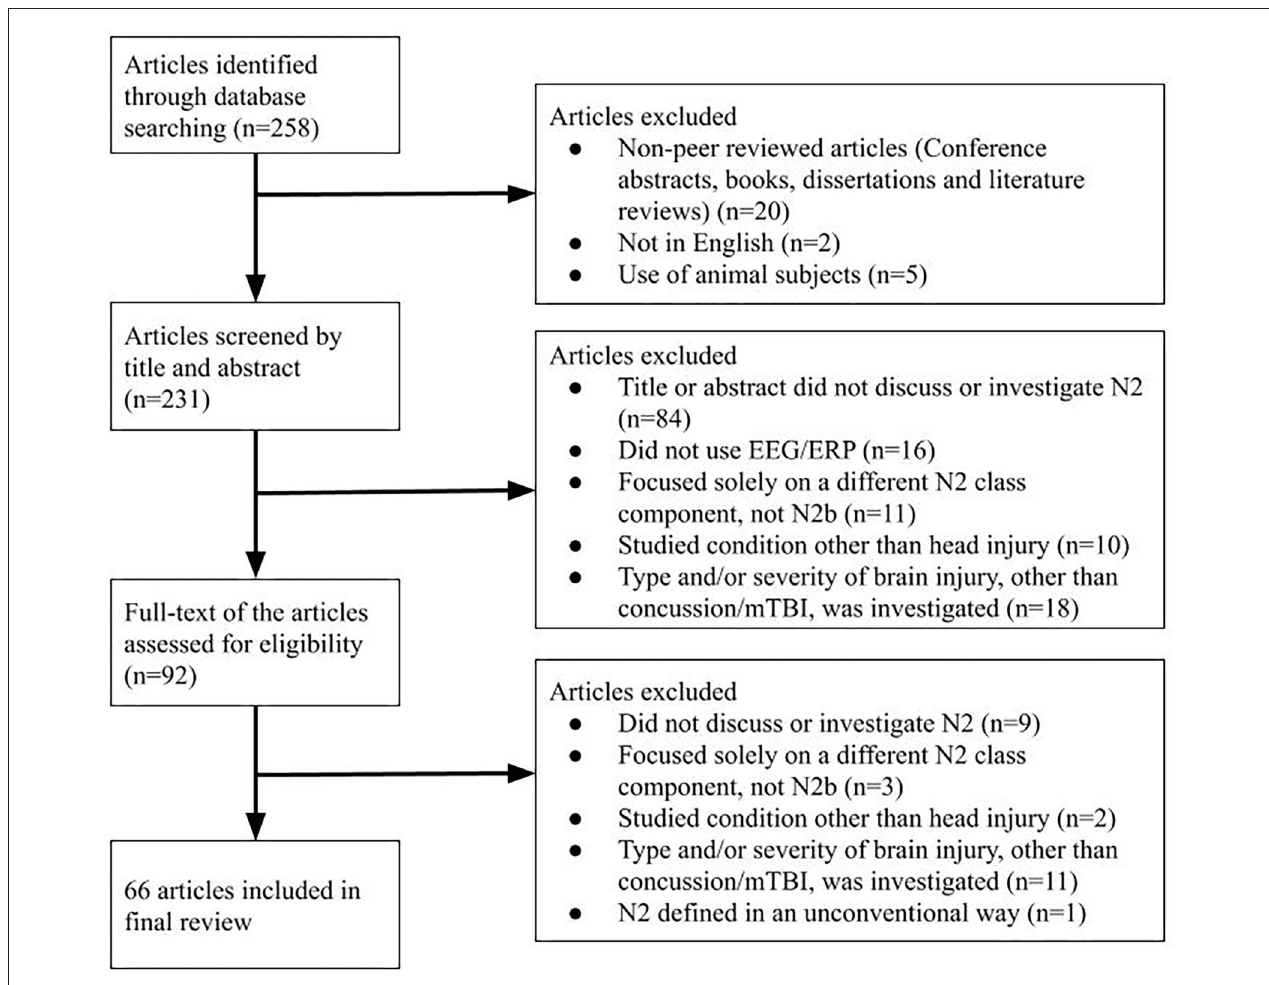
FIGURE 1 | An overview of the selection procedure, with articles included and excluded at each step.